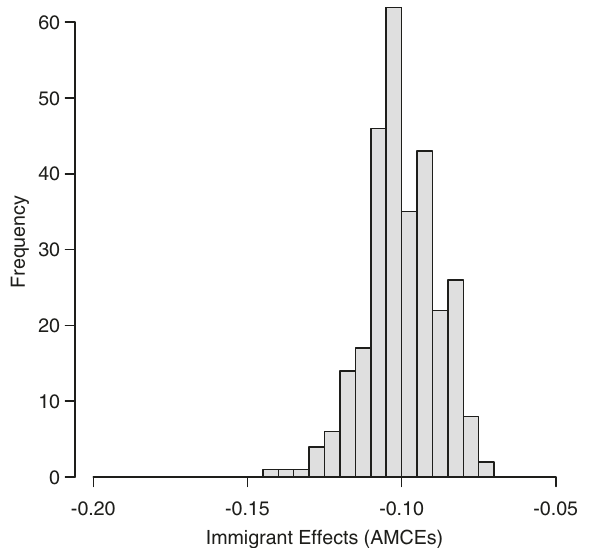
Fig. 3 Distribution of Immigrant Effects (AMCEs) across J = 288 unique pro fi le combinations. Pooled survey waves 1 – 23.